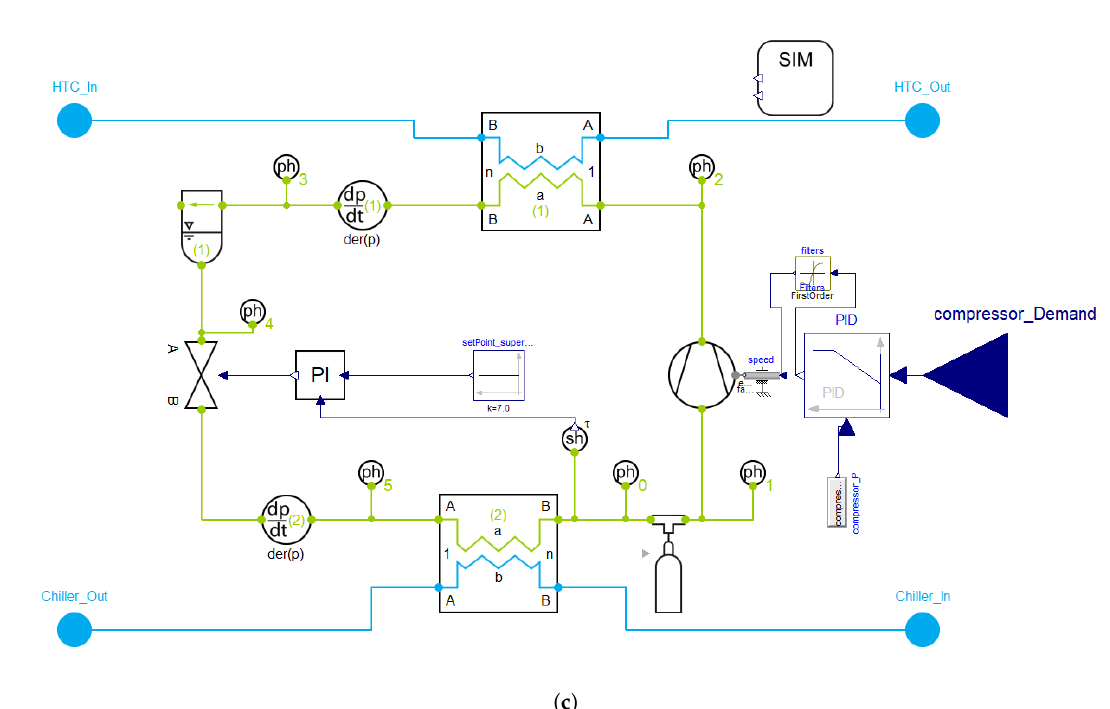
Figure 4. The top level of the heat pump model, ( a ) is used to connect vehicle components to the heat pump via switches seen across the top of the figure. These switches are controlled by external controller to either connect or isolate a component to/from the heat pump. The middle level of the heat pump model, ( b ) is used to interface the components with the coolant circuits contained in the HTC and Chiller components labelled in the figure. Here parametrised heat exchangers control the thermal exchange between the component and the coolant loops. The lowest level of the heat pump model, ( c ) contains the refrigeration circuit, moves heat from the chiller loop to the HTC loop via the evaporator and condenser. The refrigeration loop was modelled using the Thermal Systems library from TLK